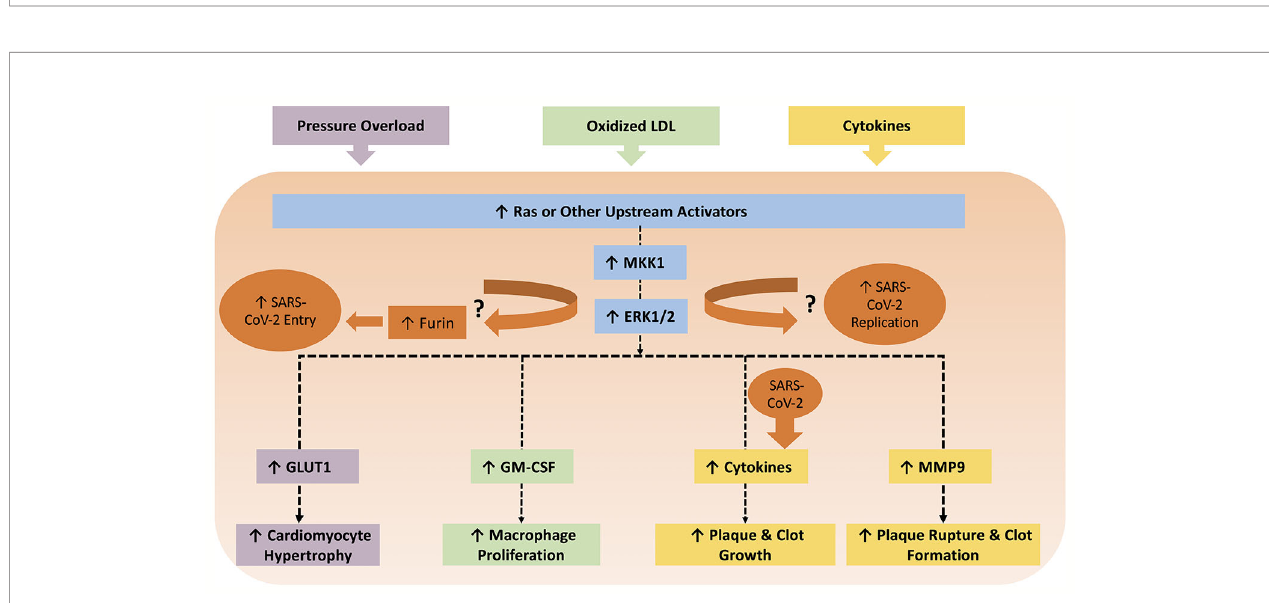
FIGURE 2 | The MAPK pathway can be induced by several triggers in various cells within the context of CVDs. For example, pressure overload can cause hypertrophy in cardiomyocytes via the ERK1/2/GLUT pathway. Oxidized LDL triggers macrophage proliferation via ERK1/2/GM-CSF, which contributes to the development of atherosclerosis. All cells involved in atherosclerosis can release cytokines in an ERK1/2 dependent manner, which ultimately propel plaque and clot growth. Cytokines can subsequently enhance MMP9 production, which leads to plaque rupture and thrombosis. Meanwhile, coronaviruses have been shown to involve p38 MAPK, JNK, and MKK1/ERK1/2 pathways for viral pathogenesis. MKK1/ERK1/2 pathway also upregulates the protease furin, which is implicated in SARS-CoV-2 entry due to the unique furin-like S1/S2 cleavage site. It is worth examining if inhibition of MKK1/ERK1/2 mitigates production of SARS-CoV-2 viral progeny. On the other hand, SARS-CoV-2 can also amplify production of cytokines, which can worsen existing